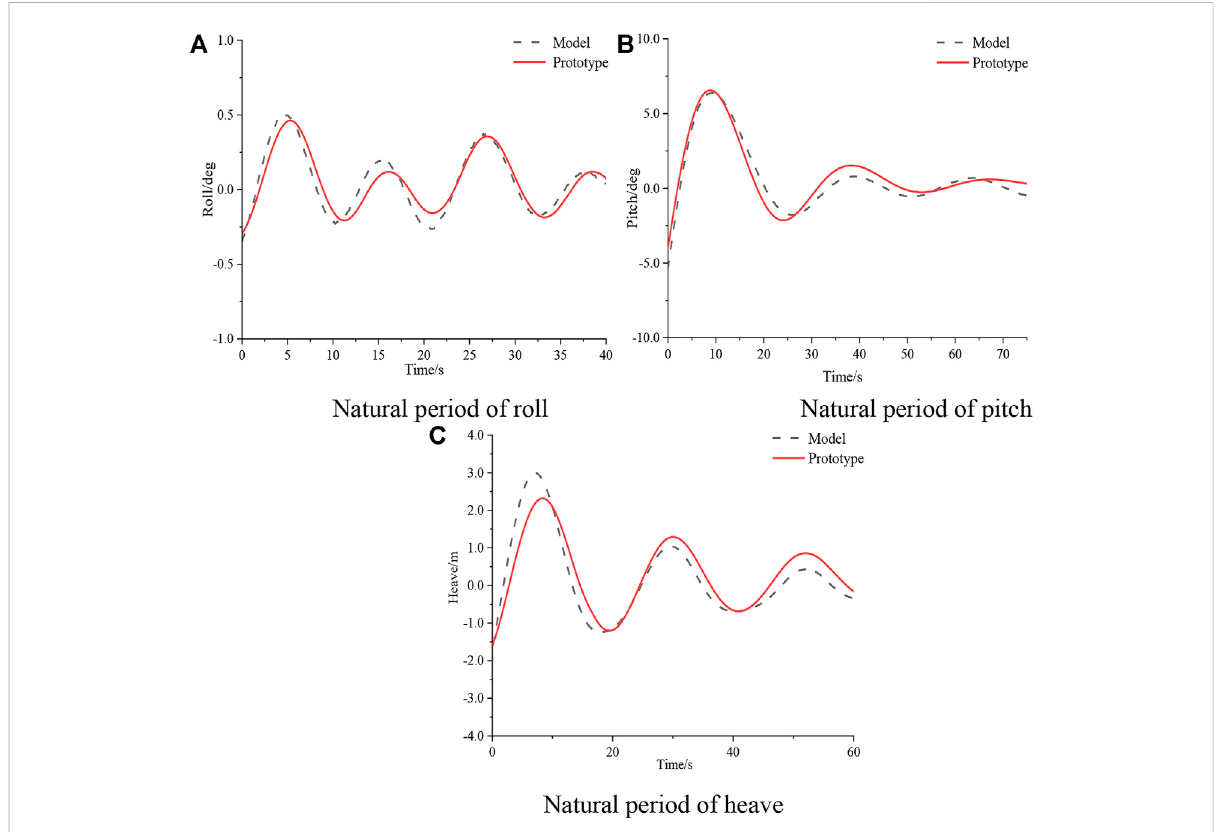
TABLE 6 The comparison between the model and the prototype. Motion